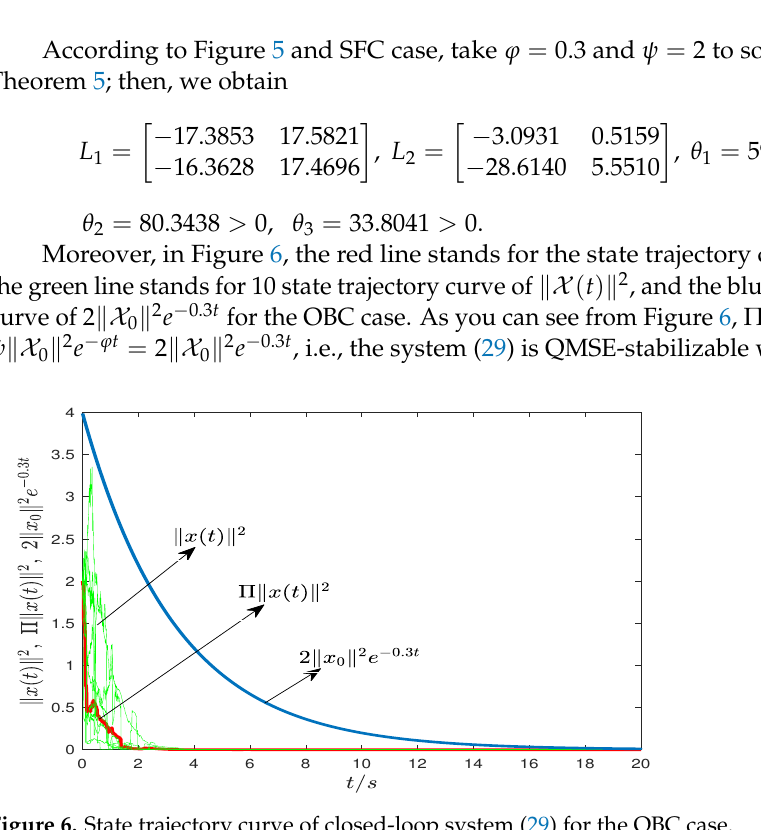
Figure 6. State trajectory curve of closed-loop system (29) for the OBC